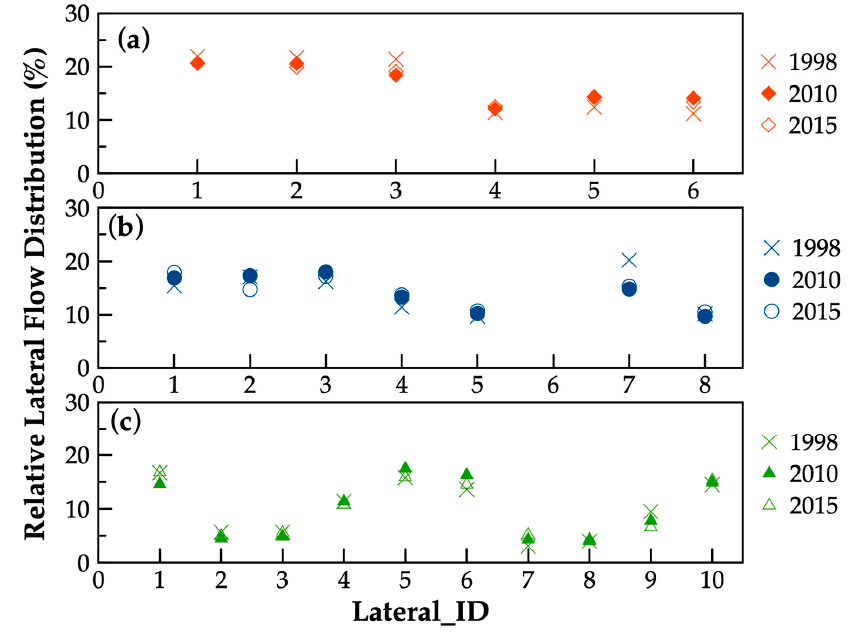
Figure 4. Relative lateral flow distribution (%) in ( a ) Collector 3, ( b ) Collector 4, and ( c ) Collector 5.